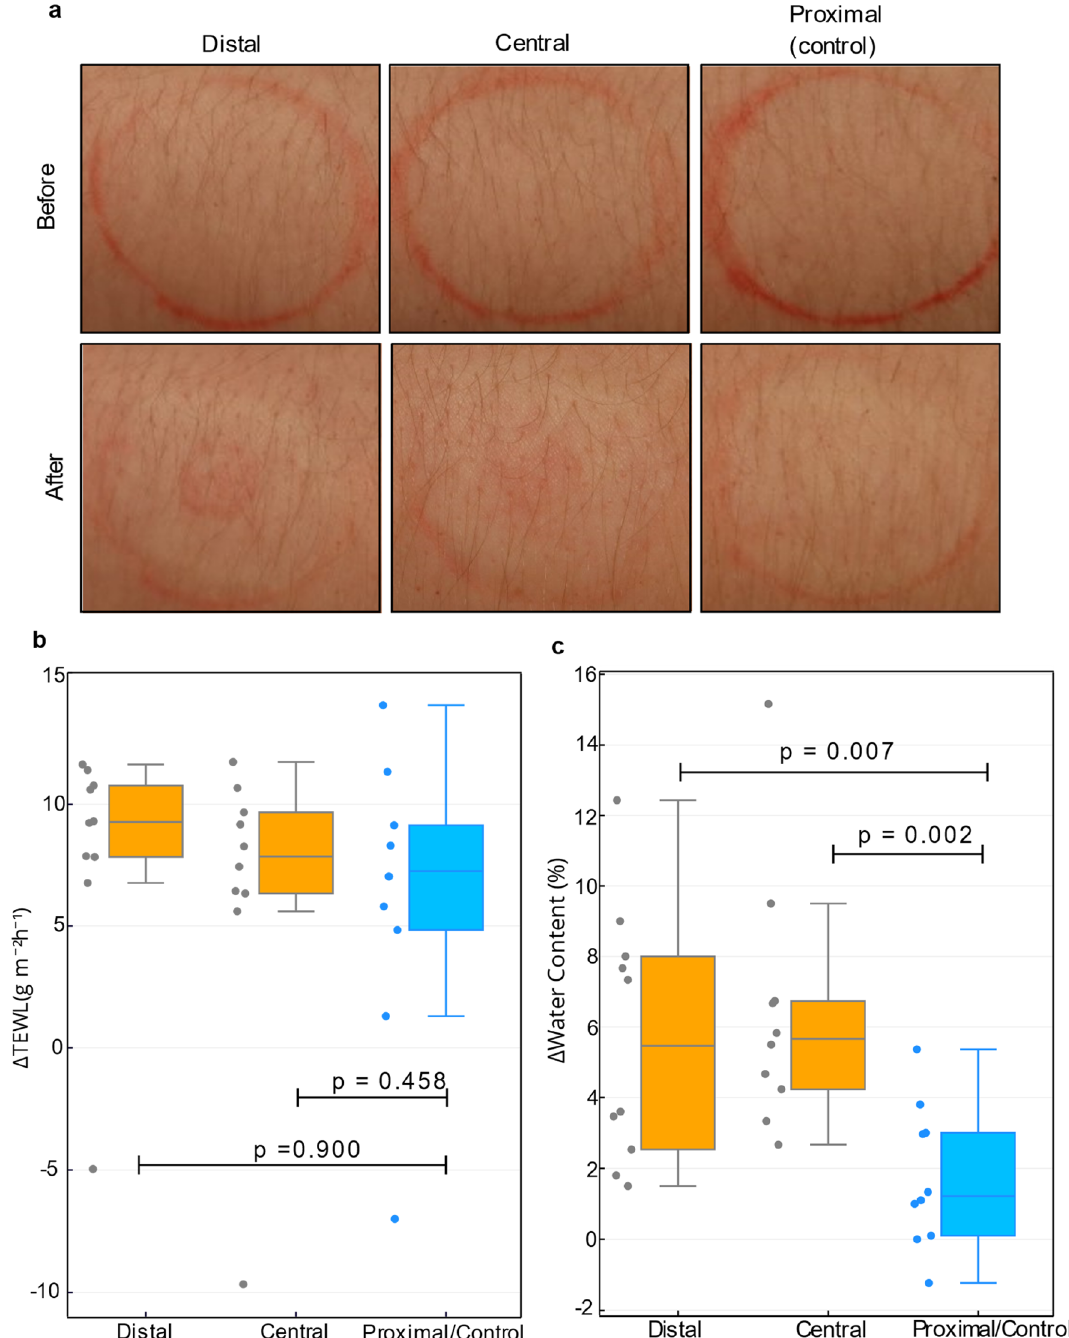
Figure 4. Effect of extraction on the skin. ( a ) Photographs of the skin MHD well sites before and after the glucose tolerance test that includes 30 extractions lasting 5 min. The extraction well outline was marked with a red makeup pen before the experiment. ( b ) ΔTEWL and ( c ) Δ skin water content for each well from all 10 experiments. Δ values were obtained by measuring the skin parameters before and after the experiment and by calculating the difference between these values (Δ = after – before). p values were obtained via t-test, with p ≤ 0.05 considered